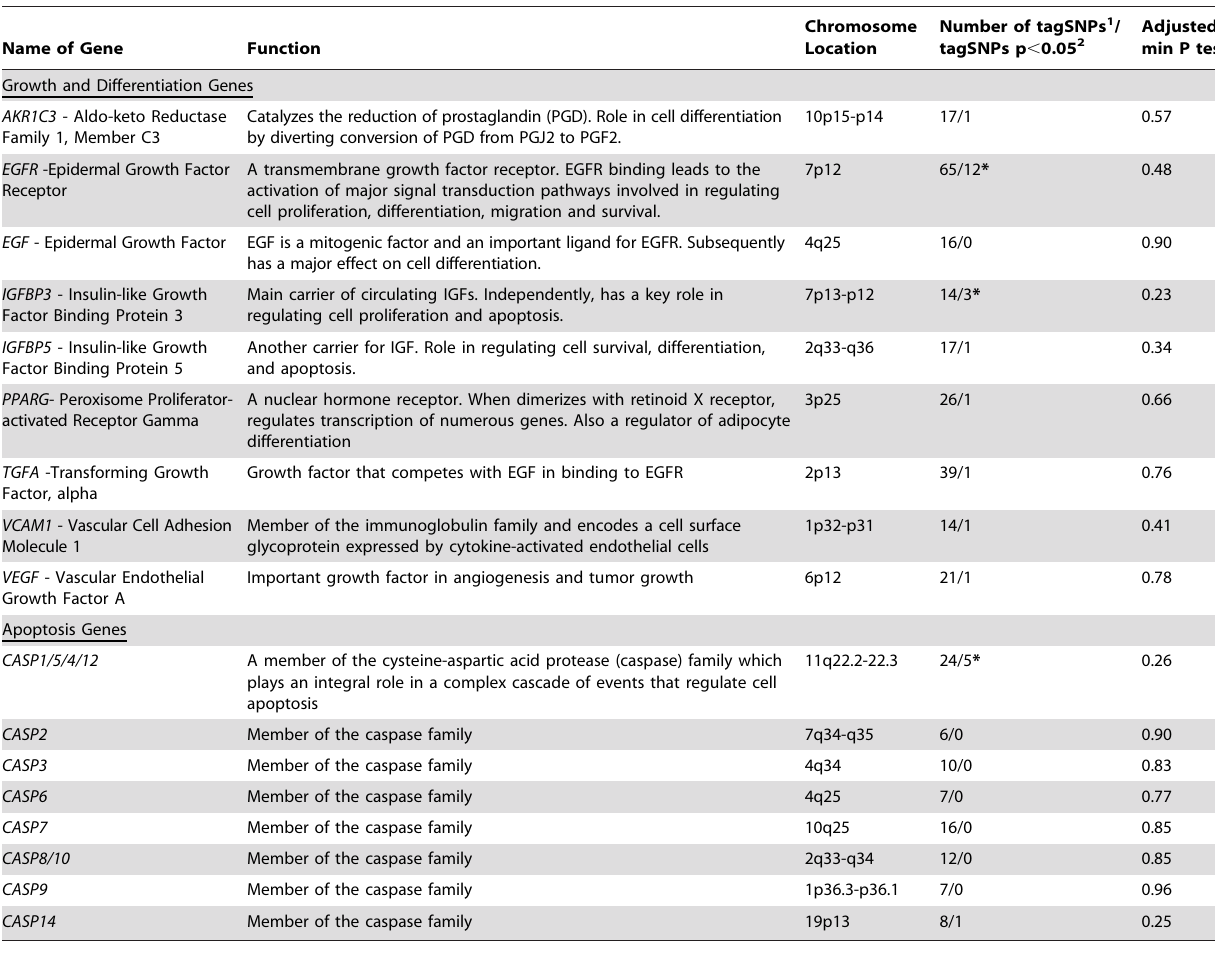
Table 1. Description of selected genes and tagging